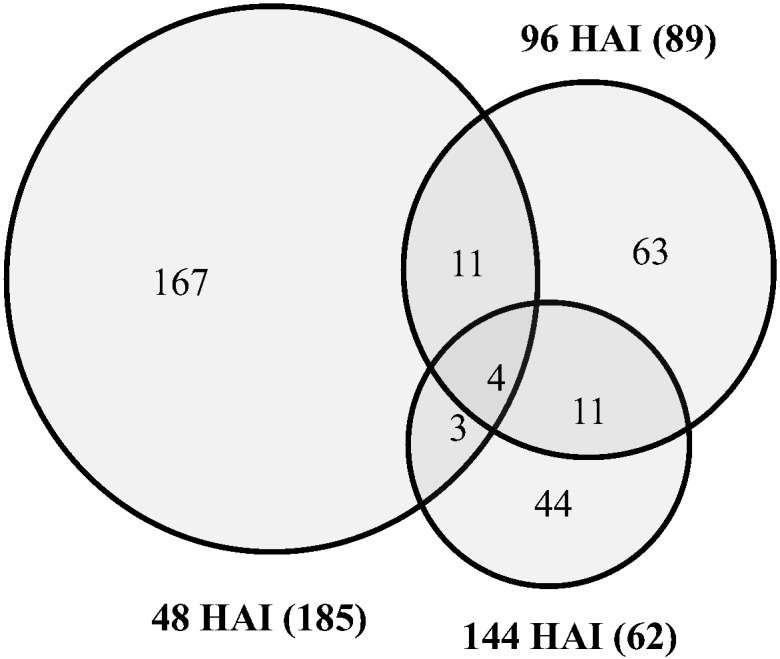
Venn diagram of exclusively up-regulated genes in 3ADON population compared to 15ADON population in planta.HAI: hours after inoculation, 3ADON: population producing 3-acetyl-deoxynivalenol and DON, 15ADON: population producing 15-acetyl-deoxynivalenol and DON. Information of genes corresponding to the Venn diagram are given in S2 Table.